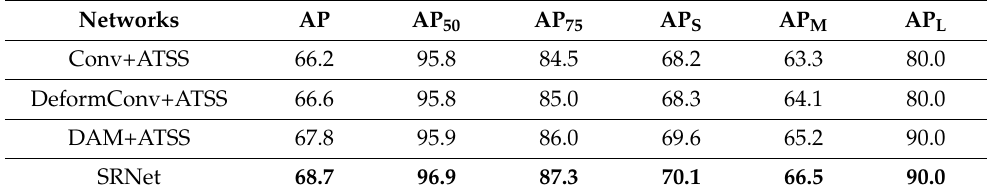
Table 6. Ablation experiment results of our network framework on the Instance-RSDD dataset.